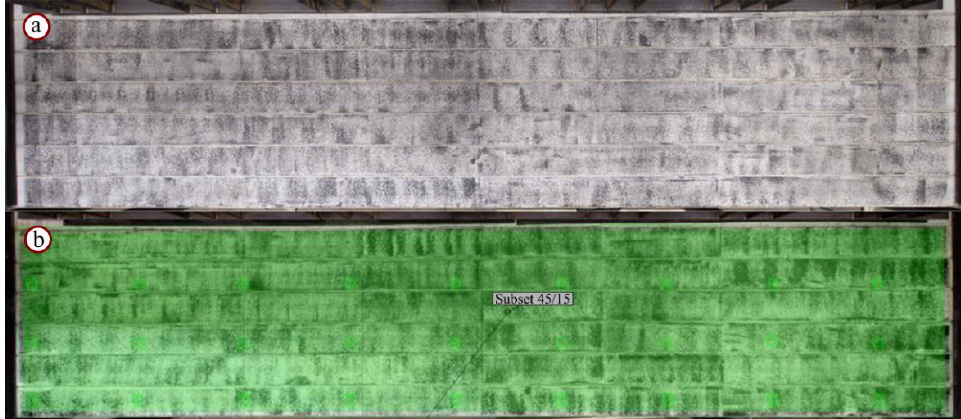
Figure 9. ( a ) Image from the lab test with pattern. ( b ) Pattern recognition for lab test, subset 45/15.